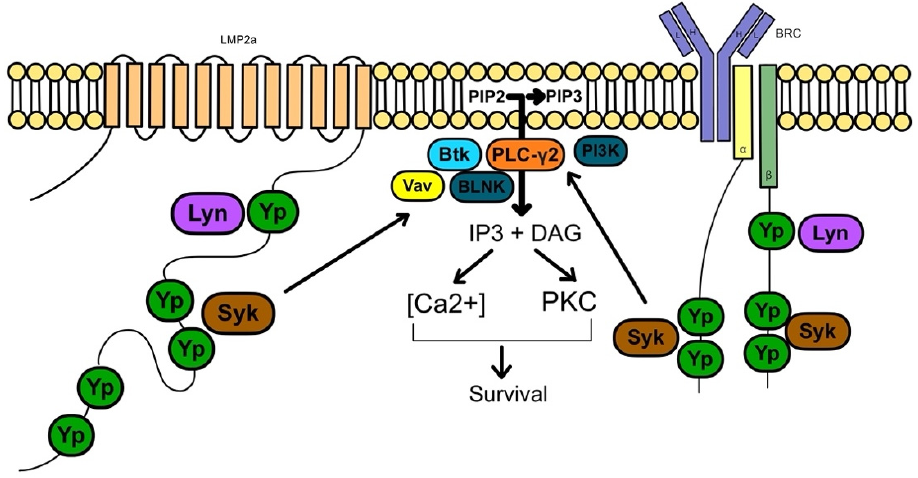
Figure 3. LMP-2A and signaling interactions with the B-cell receptor (BRC). Adapted from Thorley- Lawson, D. Epstein-Barr virus: exploiting the immune system. Nat Rev Immunol 1, 75–82 (2001).